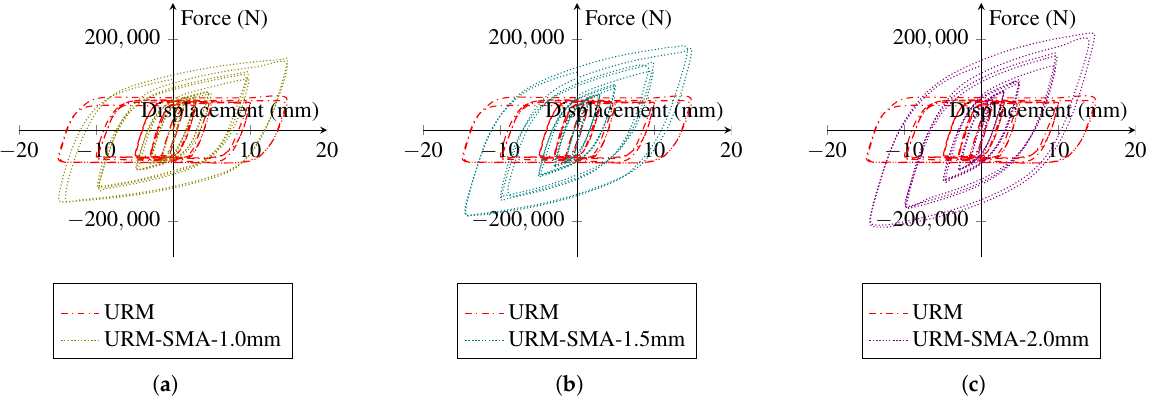
Figure 15. Effect of the variation of the thicknesses value of Ni–Ti pseudoelastic strips on the hysteresis of the masonry wall: ( a ) 1.0 mm; ( b ) 1.5 mm; ( c ) 2.0 mm.